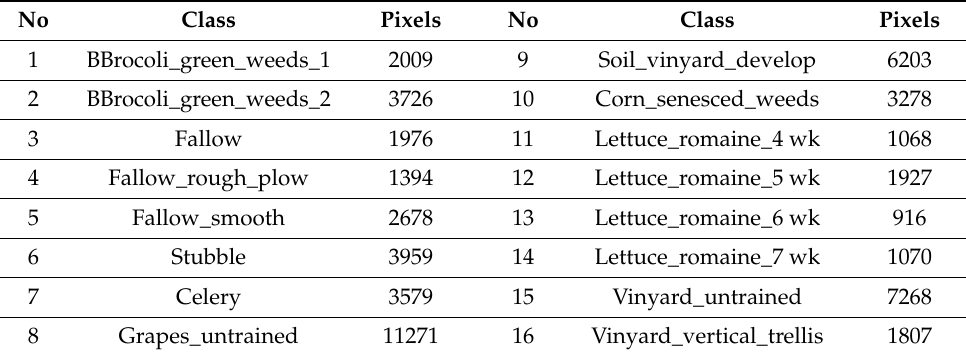
Table 4. Type of classes and their respective labeled pixels number in the Salinas dataset.